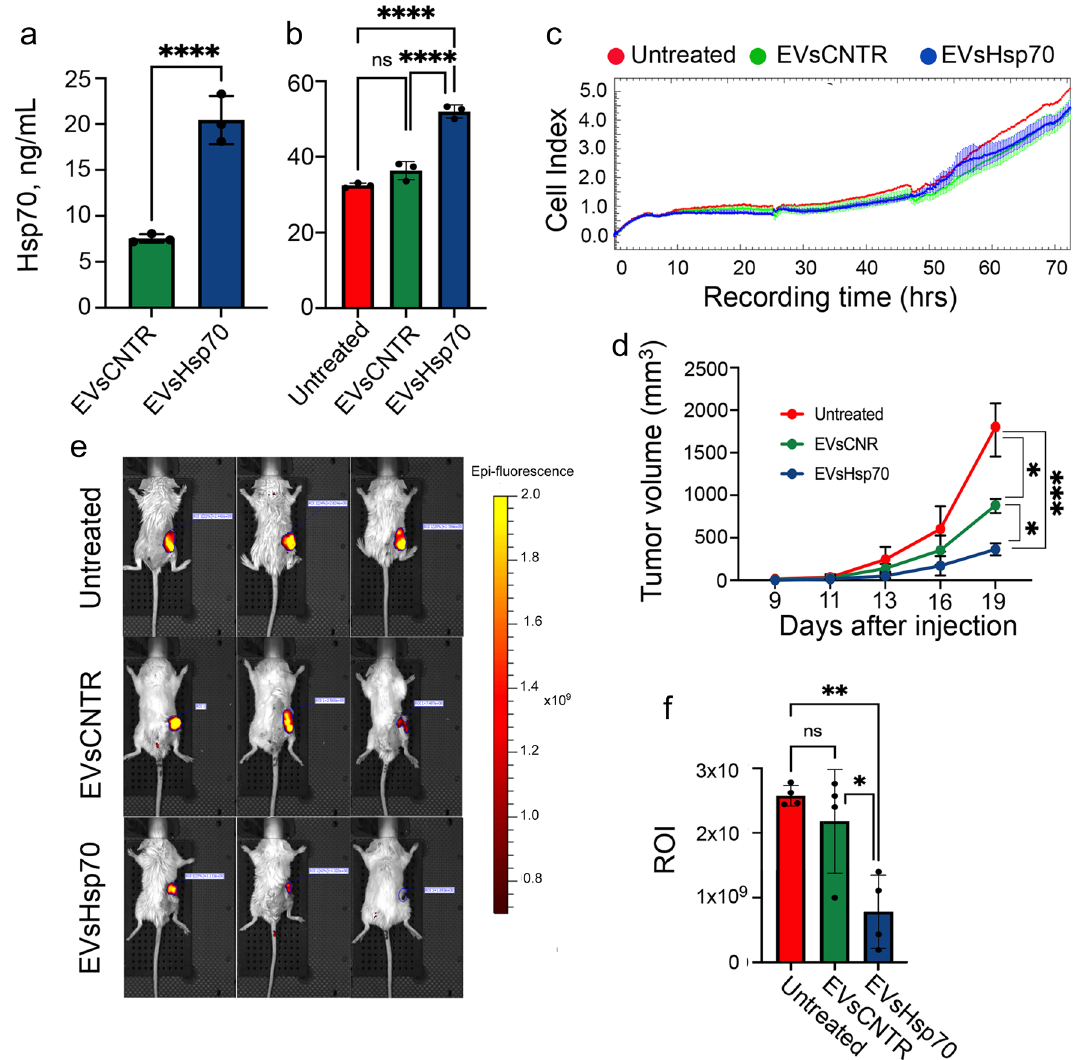
Figure 4. The antitumor effect of EVs from CT-26 cells depends on the Hsp70 content. ( a ) The level of Hsp70 was measured in EVs or ( b ) in cell lysates from CT-26, untreated and incubated with rHsp70, with the aid of Hsp70-ELISA. ****p < 0.0001. ( c ) EVs-CNTR or EVs-Hsp70 were added to CT-26 cells and their proliferation was measured using xCELLigence. ( d ) Tumor volume was measured each 2nd day, starting from day 9 in Balb/c mice (n = 10 in each group) ***p = 0.0003; *p = 0.0371; 0.0428. ( e ) Tumors were monitored using the IVIS Spectrum imaging system (filters: excitation: 675 nm, emission: 720 nm). Representative biofluorescence images. ( f ) Fluorescence count of tumor lesions, (**p = 0.0043, *p = 0.0182, Dunnett’s multiple comparison